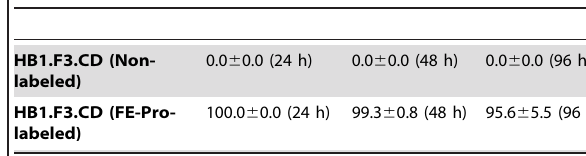
Table 1. Retention of FE-Pro label in HB1.F3.CD